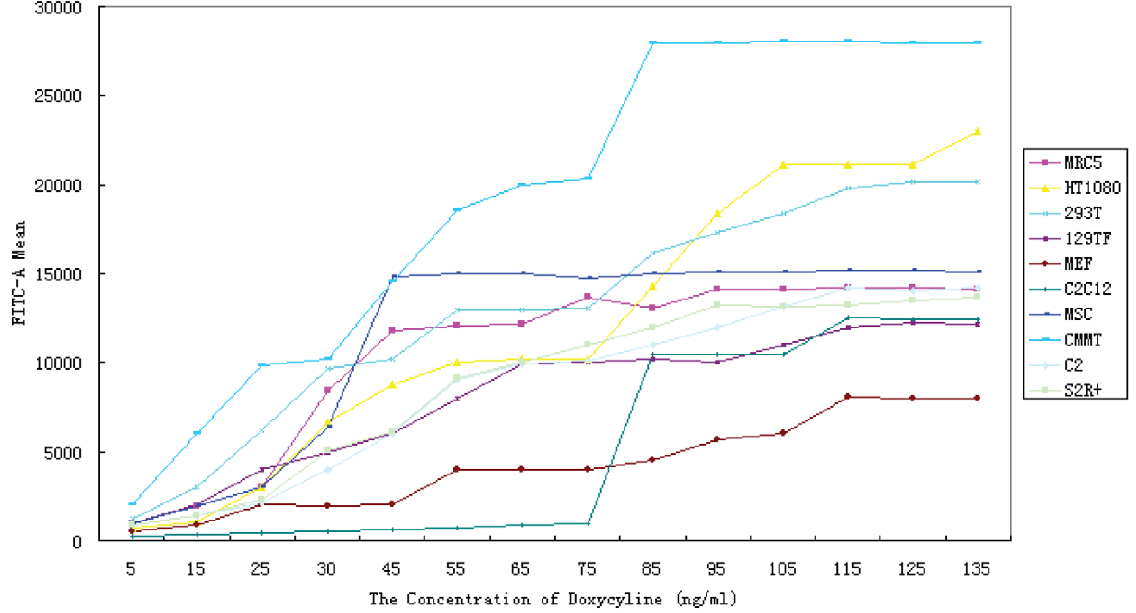
Figure 3. Induction of TRE promoter driving GFP under different doses of doxycycline. Eight mammalian cell types and two Drosophila cell types were used in the analysis. GFP fluorescence is quantitated by flow cytometry.